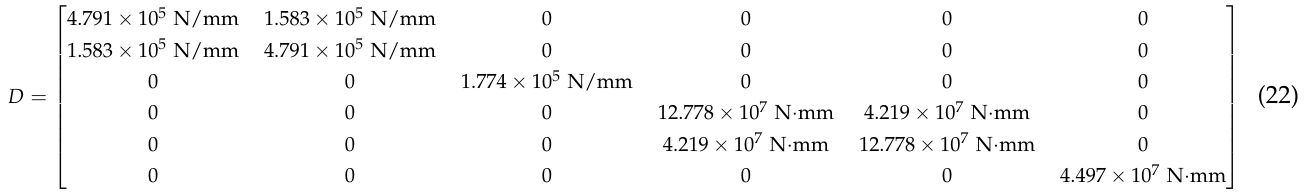
Figure 6. Schematic of Bi-layer lattice sandwich unit cell.